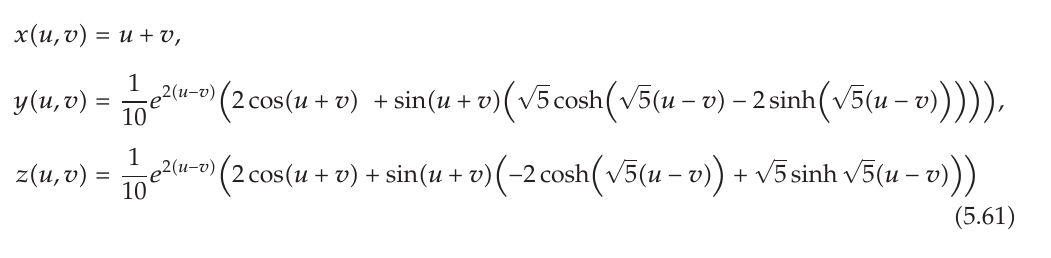
Example 5.9. A surface with